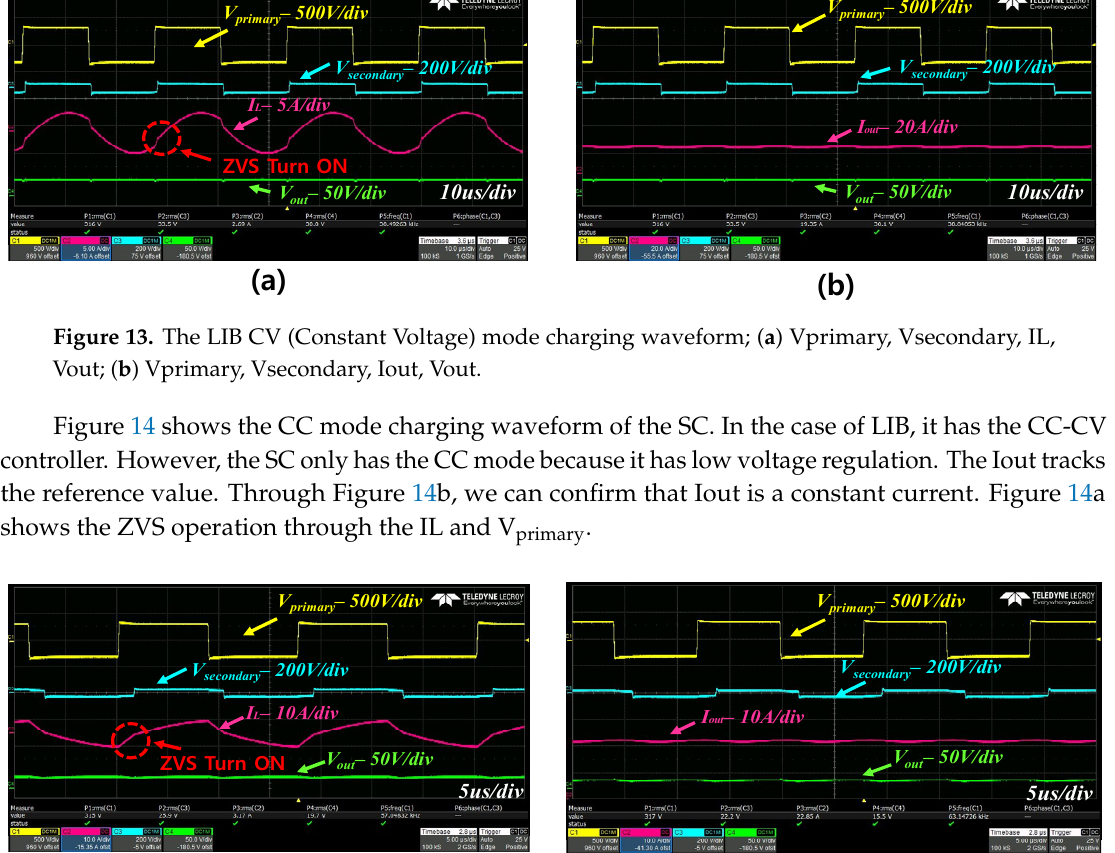
Figure 15. ( a ) The CC-CV mode charging waveform without the compensator; ( b ) the improved CC- CV mode charging waveform.